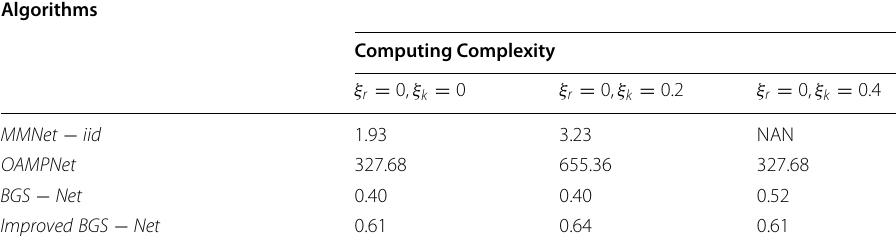
Table 2 When N t = 8,N r = 64 , the required complexity corresponding to Figure 28 (calculated according to Table 1, based on the complexity of MMSE, NAN indicates that the performance cannot be achieved at this time)